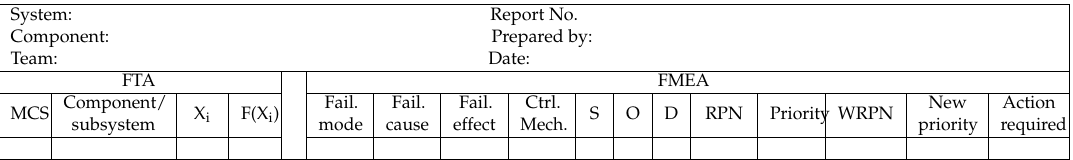
Table 2. An integrated FTA-FMEA